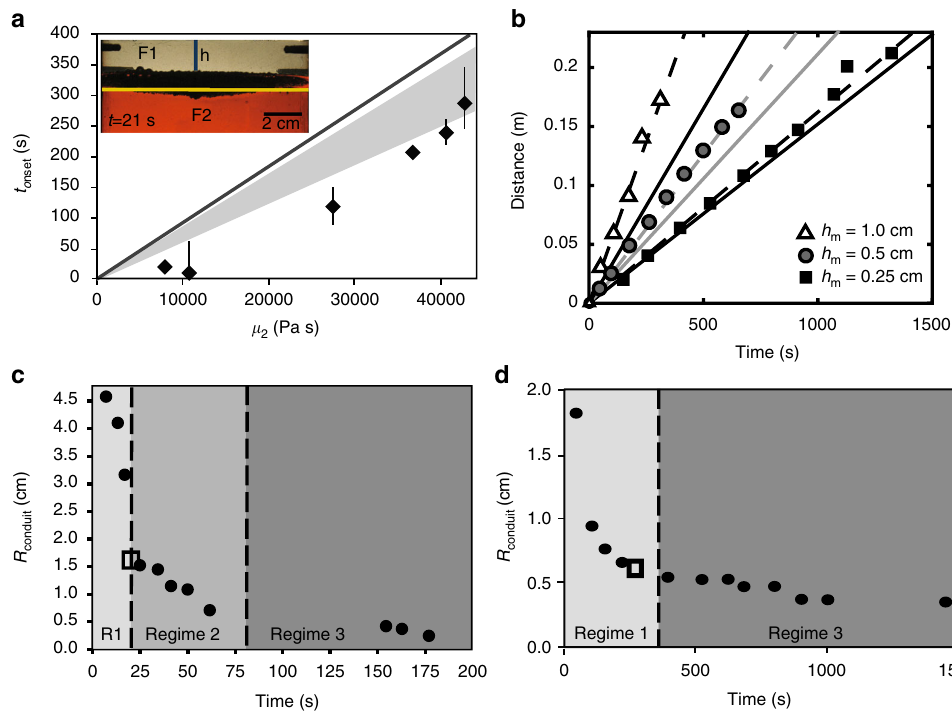
Fig. 4 Diapir descent and conduit formation. a The measured onset time (two standard deviations) versus the viscosity of fl uid S2 (black diamonds). The onset time is de fi ned by the time when the horizontal metal pond layer begins to go unstable and sinks crossing the S 1 − S 2 interface (yellow line, inset photograph). Theoretical prediction (black line) for onset of a Rayleigh − Taylor instability, Eq. (1) . Shaded region is revised theory using Eq. (5) for the range h 1 from 2.5 to 4.2 cm. Experimental Data 8, 10, 11, 18, 21, and 24. b Descent distance versus time for a diapir during terminal velocity for three